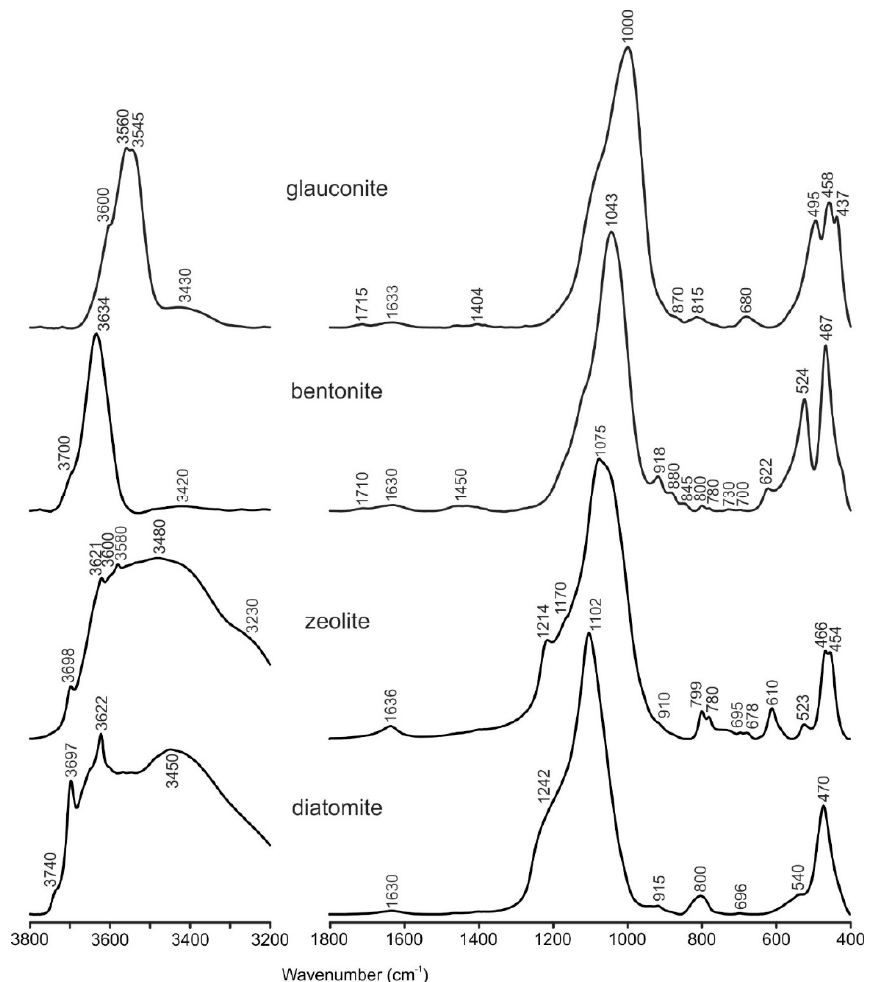
Figure 2. FTIR spectra of natural sorbents.